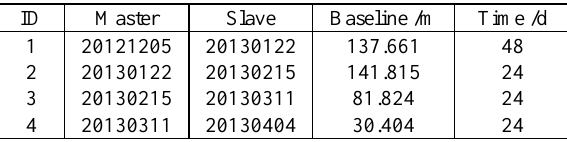
Table 2. Parameters of interferometric pairs